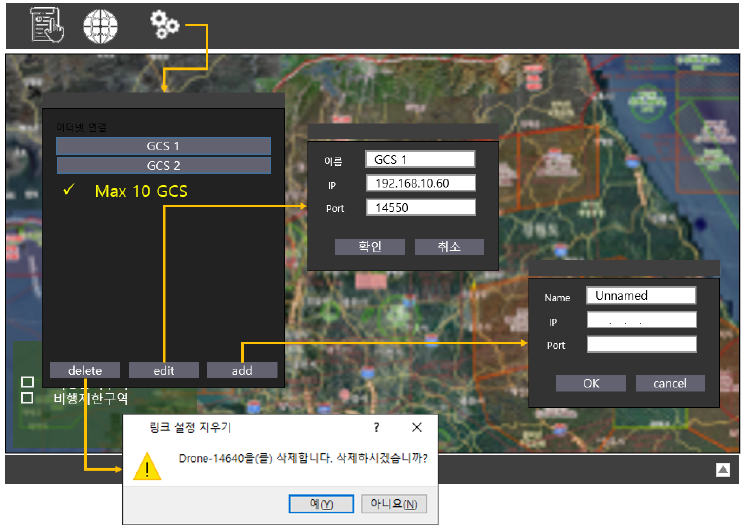
Figure 7. UTM UI—GCS connect window.